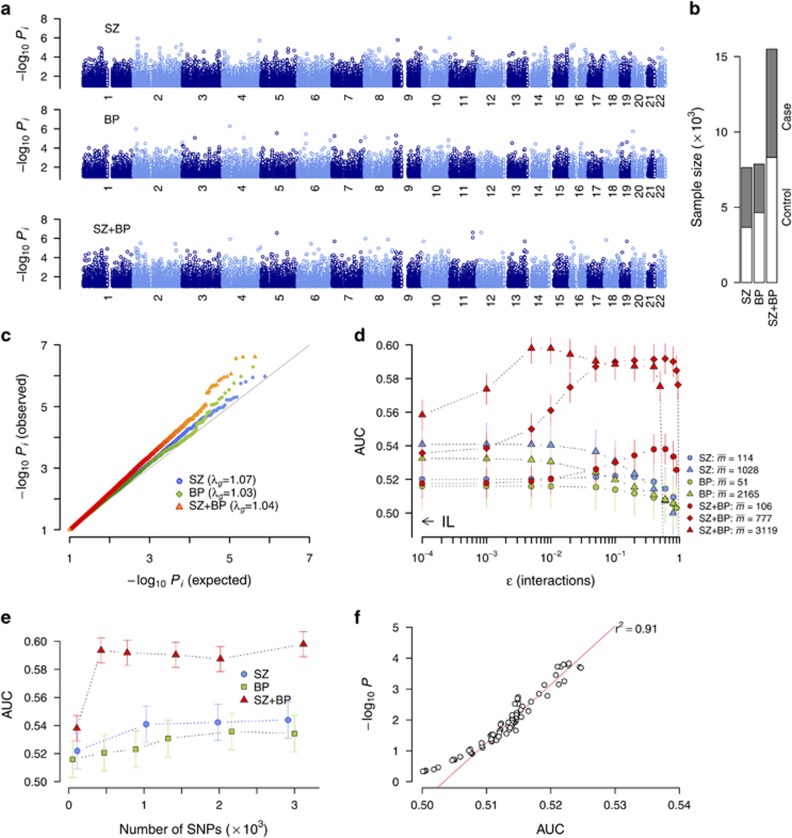
Disease association in independent loci and collective interaction analyses. (a) Independent loci (IL) P-value Pi for schizophrenia (SZ), bipolar disorder (BP) and SZ+BP data. (b) Sample sizes (see Supplementary Table 1). (c) Quantile–quantile plots and inflation factor λg. (d) Variations in the area under curve (AUC) with interaction strength ɛ. Single-nucleotide polymorphisms (SNPs) were selected based on Pi during cross-validation. The mean number of SNPs are shown in legend. (e) Dependence of maximum AUC on mean number of SNPs. (f) Correspondence between AUC and P-value of SNP sets. The red line is linear regression for AUC >0.51. Error bars and vertical lines, 95% confidence interval.